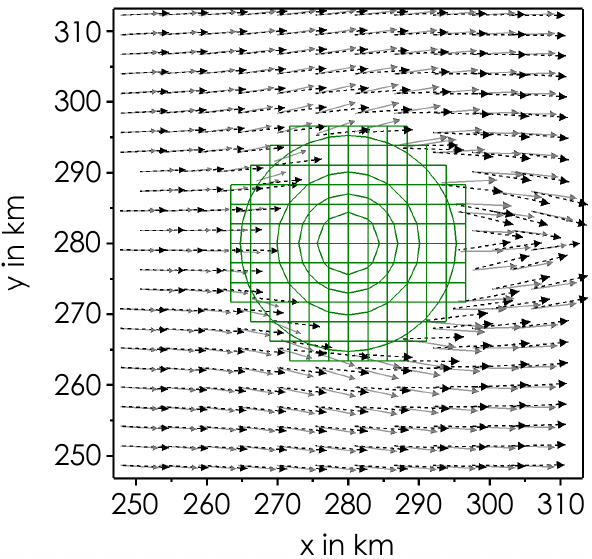
Figure 15. Convergence study for the annulus advection test. L1 (red) and L-infinity (green) error norms for the full domain and reference line (blue dotted) for "perfect" 2nd order convergence. Figure 17. Horizontal cross-section of horizontal wind vectors at z = 200 m height for the RH95 case (black) and the RH50 case (grey). Surface grid cells around the mountain in green, circle lines represent 200 m orography intervals.